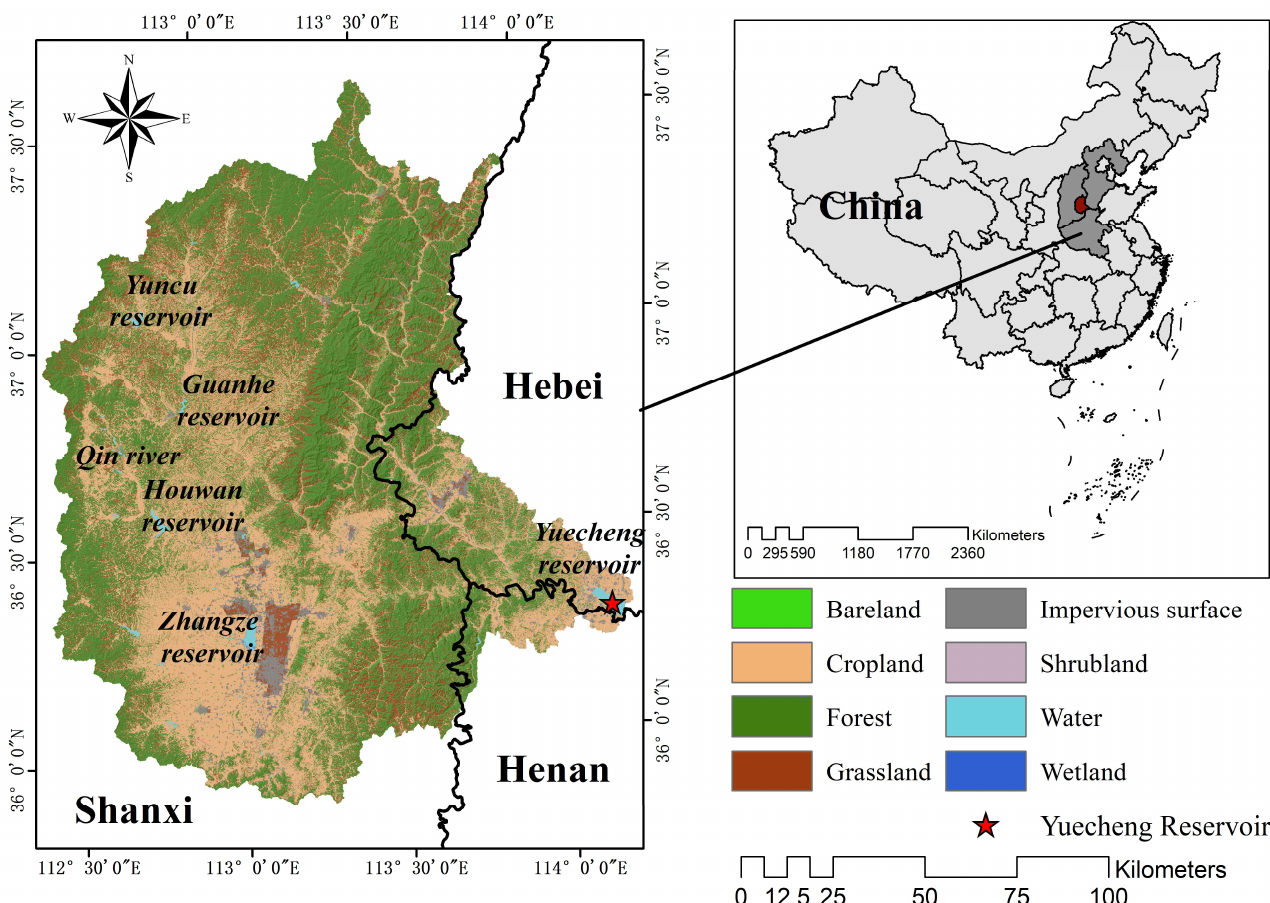
Figure 1. Location of the study area (Yuecheng Reservoir catchment). The red star in the southeast of the left side is Yuecheng reservoir. Yuecheng Reservoir is located in Hebei Province but most of its catchment area (the study area) is located in Shanxi Province. Land-cover classification of the study area obtained from Global Land Cover (GLC) 2017 shows that cultivated land covers a vast area and is an important type of land use.